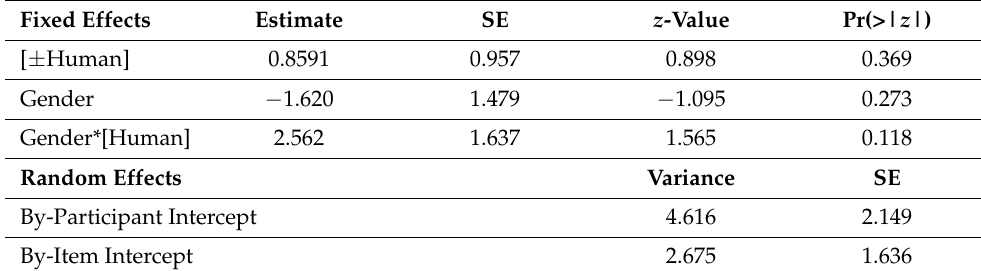
Table 5. Linear mixed-effects model, picture selection task, L1